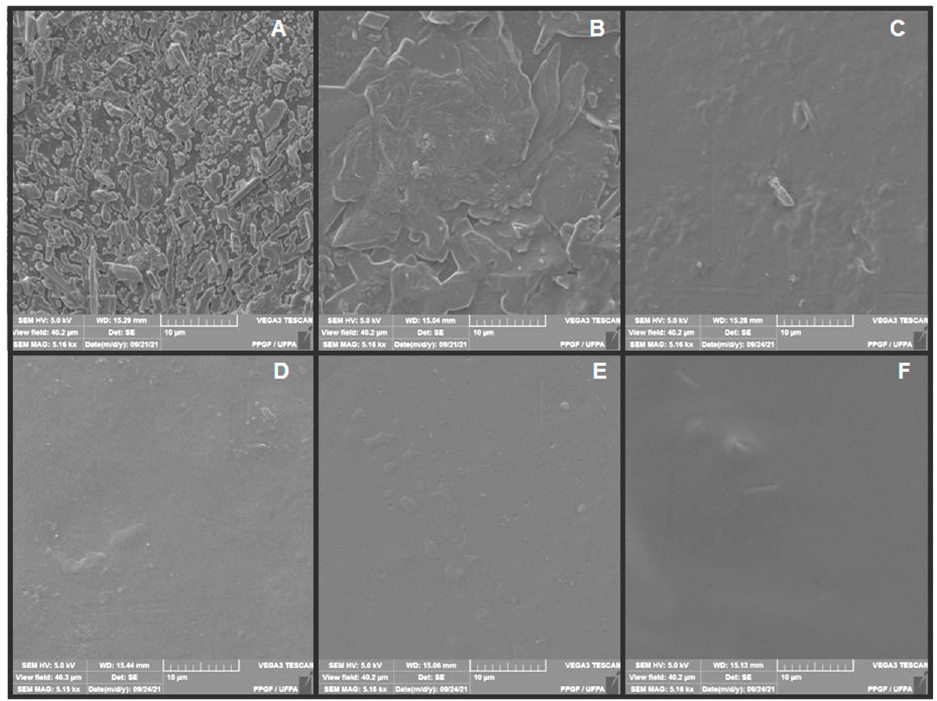
Figure 8. Micrographs obtained by SEM of membranes at the amplitude of 5 kv: ( a ) M6, ( b ) M7, ( c ) M8, ( d ) M9, ( e ) M10, ( f ) M11. A 10 μ m bar.